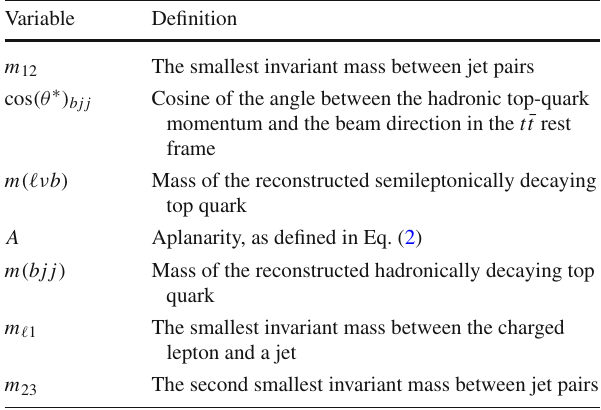
Table 2 List of the seven input variables of the NN, ordered by their discriminating power